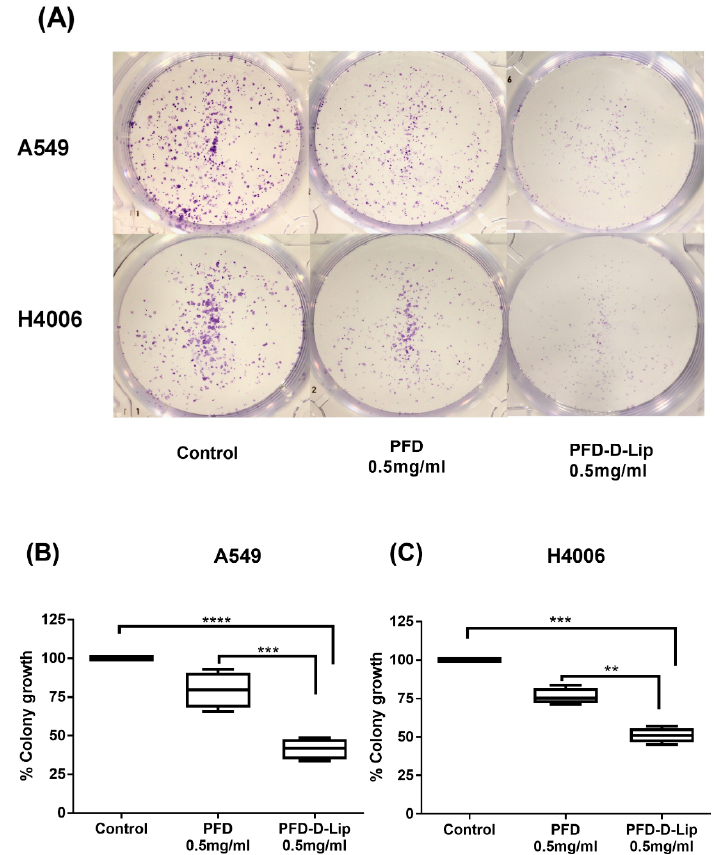
Figure 8: A549 and H4006 cells were treated with control, PFD and PFD–D-Lip at 0.5 mg/mL for